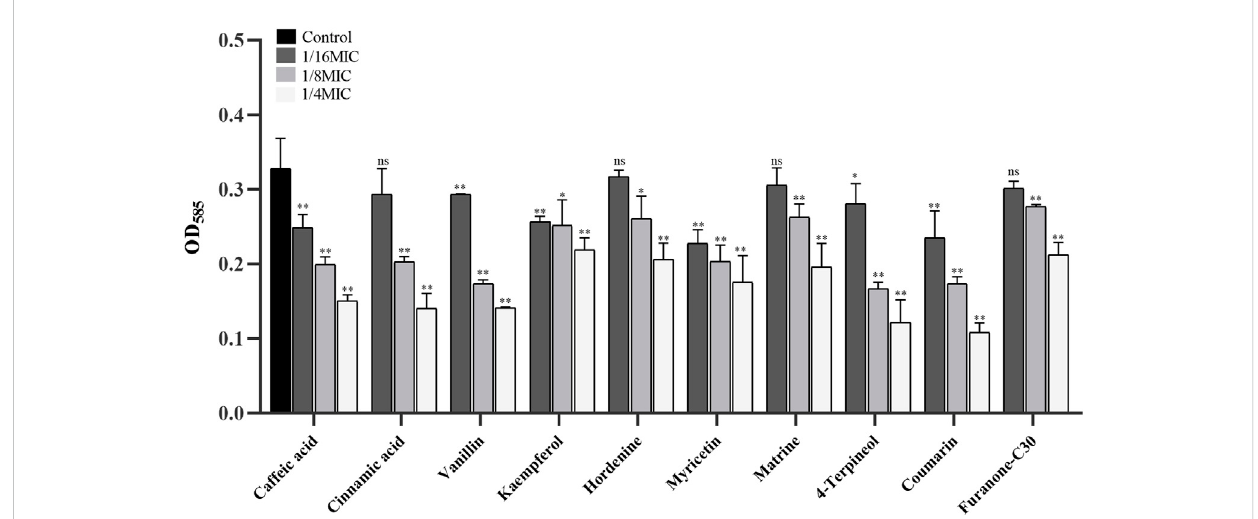
FIGURE 1 Effect of 9 TCMMs on the violacein production of CV026 at 1/4, 1/8 and 1/16MIC. TCMMs, traditional Chinese medicine monomers; MIC, minimal inhibitory concentration; CV026, Chromobacterium violaceum 026; Furanone C30, drug control; ** , p < 0.01 ; * , p < 0.05 ; ns, p > 0.05.